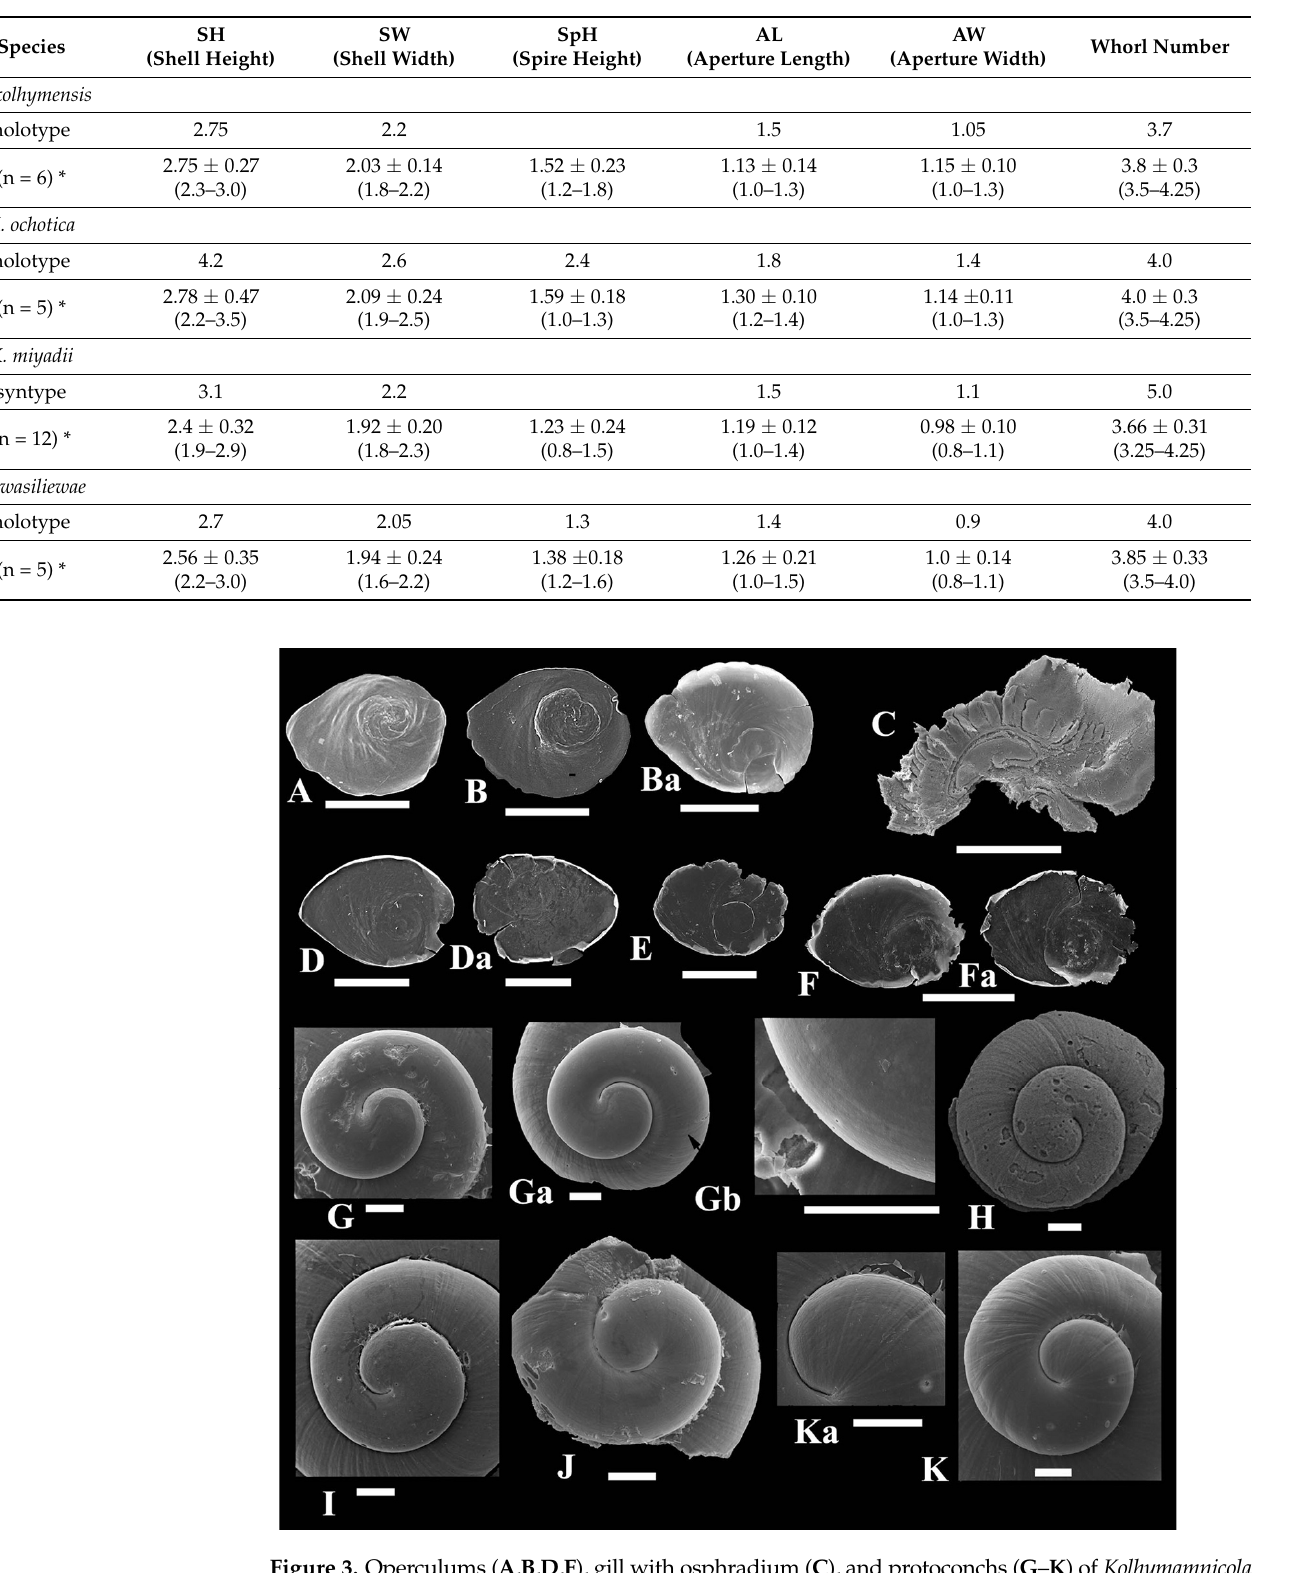
Table 3. Shell size (in mm) of the Kolhymamnicola snails, syntype of K. miyadii adapted from [14], holotypes of 3 other species adapted from [13], and own data maked *, mean ± st. dev. (minimum– maximum), in mm.